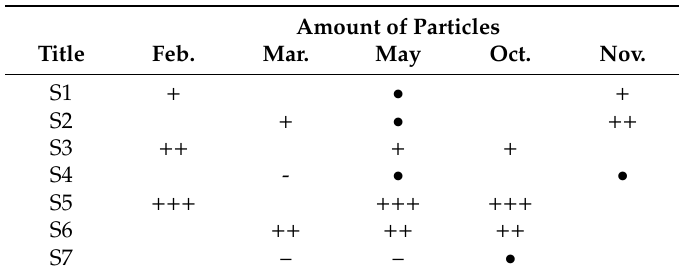
Table 3. Amount of coarse